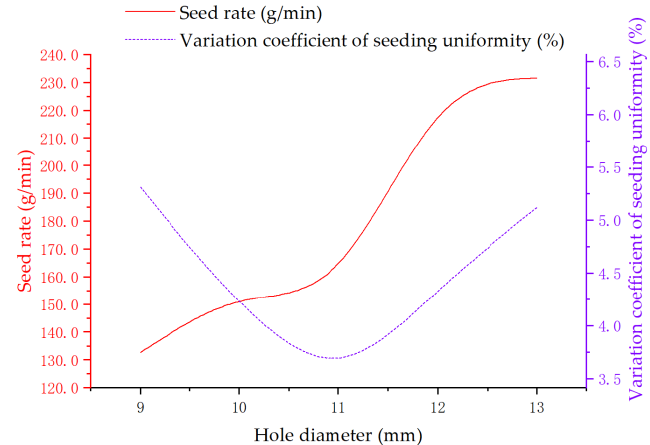
Figure 11. Relationship curve between hole diameter and indexes.